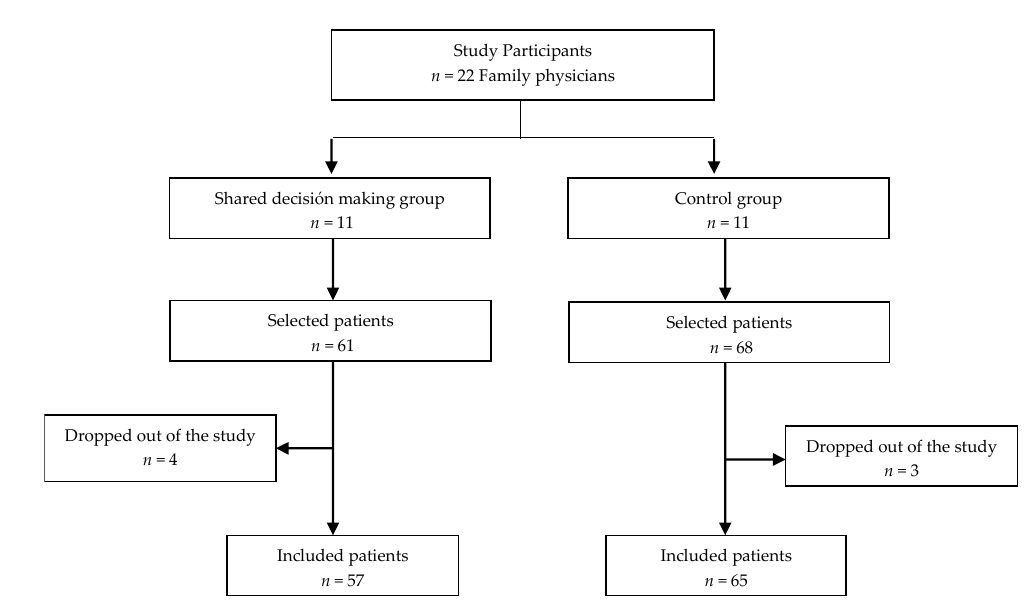
Figure 1. Participant flowchart.